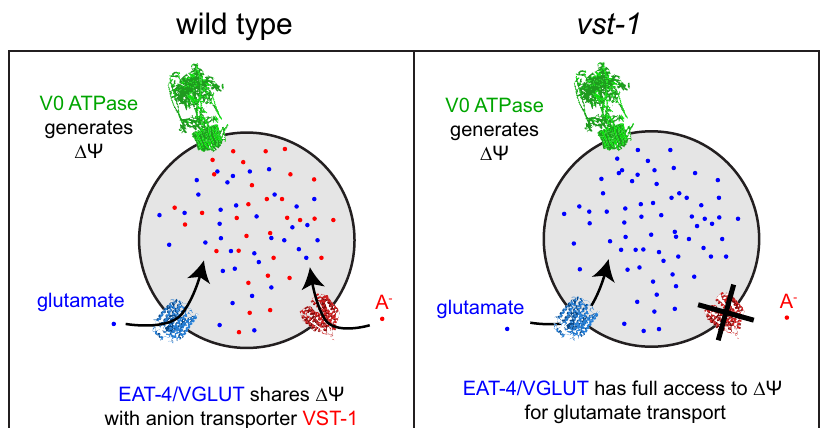
Fig. 7 A model for VST-1 regulation of glutamate transport into synaptic vesicles. A transmembrane potential Δ Ψ generated by the vesicular ATPase is harnessed by VGLUT to transport glutamate (illustrated as blue dots) into synaptic vesicles. In our model, VST-1-mediated transport of an anion (A − , red dots) into the vesicle dissipates Δ Ψ and thereby reduces glutamate